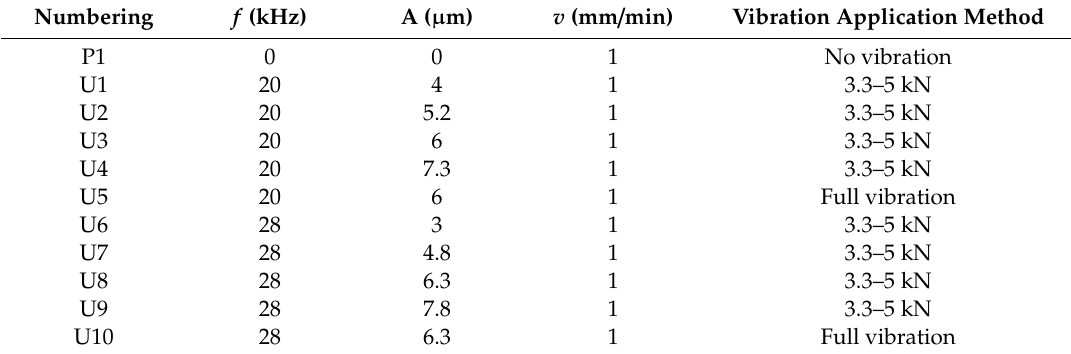
Table 8. The tensile experimental design.